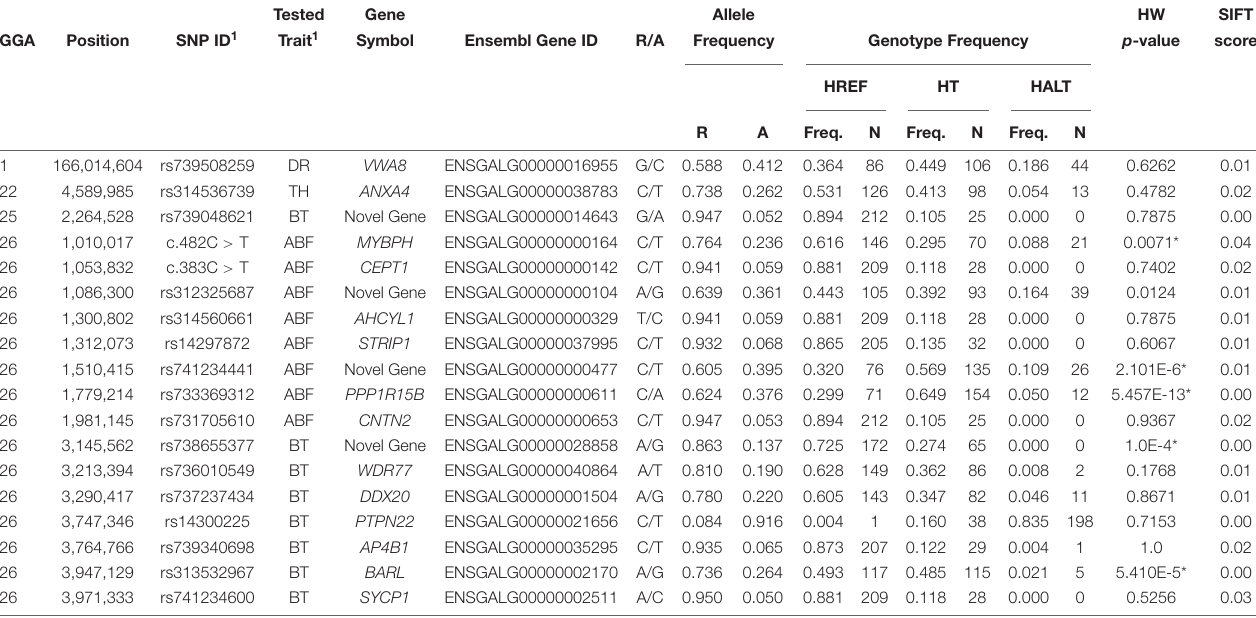
TABLE 4 | Deleterious SNPs selected for the association analyses with carcass traits. Tested Gene Allele HW SIFT GGA Position Ensembl Gene